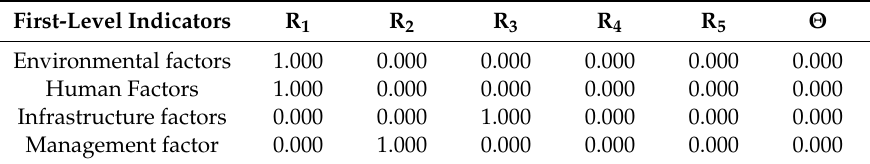
Table 6. Results of Mass function of primary